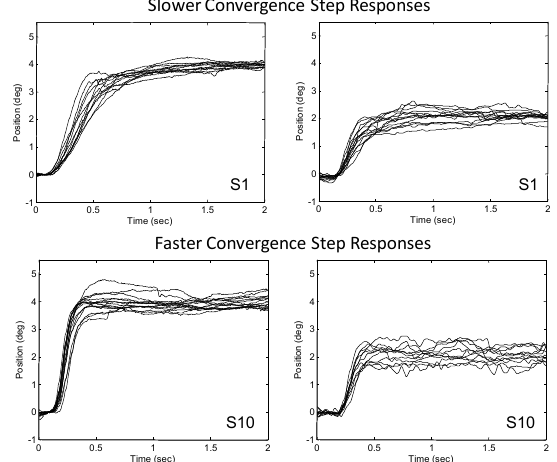
Figure 2: Model responses from (A) Dual-mode model and (B) Switched-channel model using parameters reported in the literature. In the dual-mode model response, the blue line is the transient component while the red line shows the sustained component. In the switched-channel model, the five channels are represented by yellow, turquoise, purple, red and blue respectively. Both models show the combined response in green. Note, the time scales are different between the models.